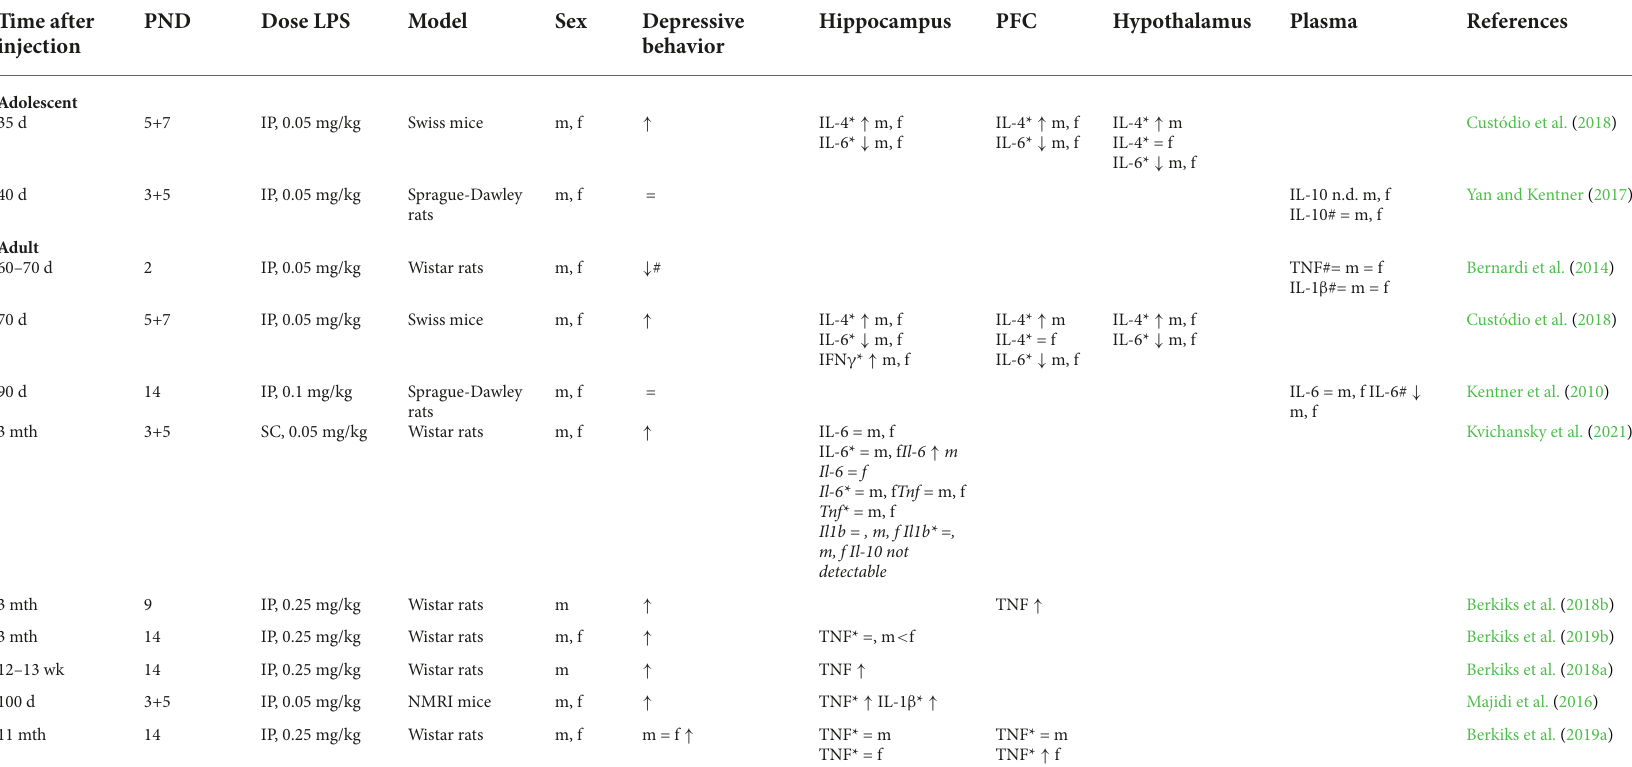
TABLE 5 The influence of neonatal administration of LPS on